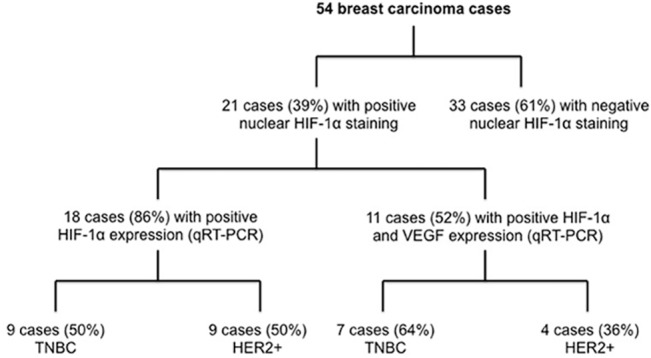
The percentage of TNBC and Her2 + cases with positivenuclearexpression of HIF-1α that expressed HIF-1α and VEGF transcripts fold change.